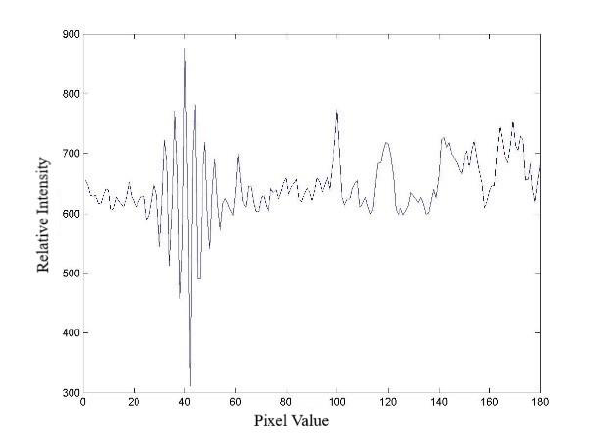
Figure 3. Original